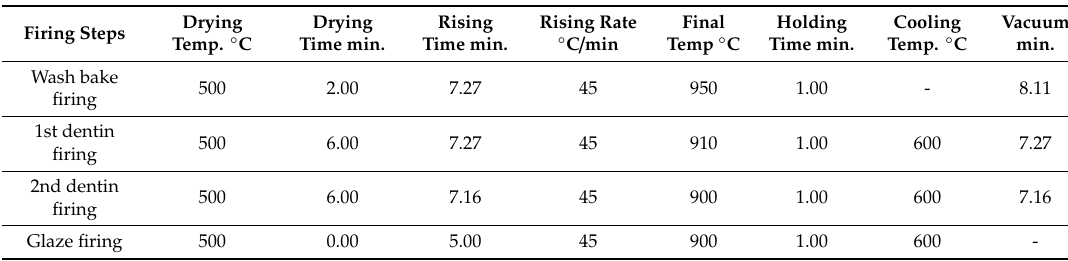
Table 3. Firing steps for Vita